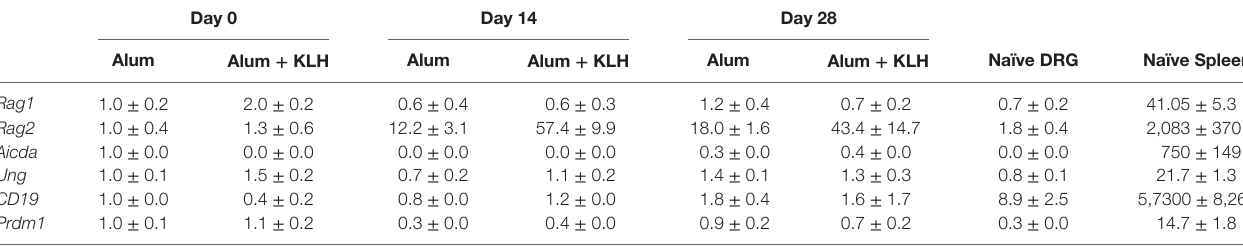
TaBle 3 | In vivo analysis of gene expression by